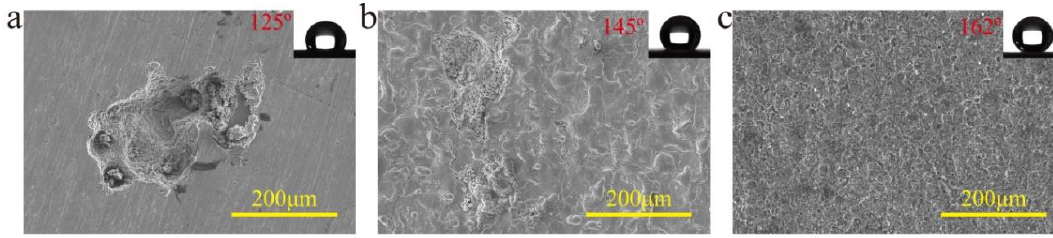
Figure 6. SEM images of surface morphology of different surfaces after ECE. ( a ) Original surface, ( b ) EDM surface without cracks, ( c ) EDM surface with cracks.